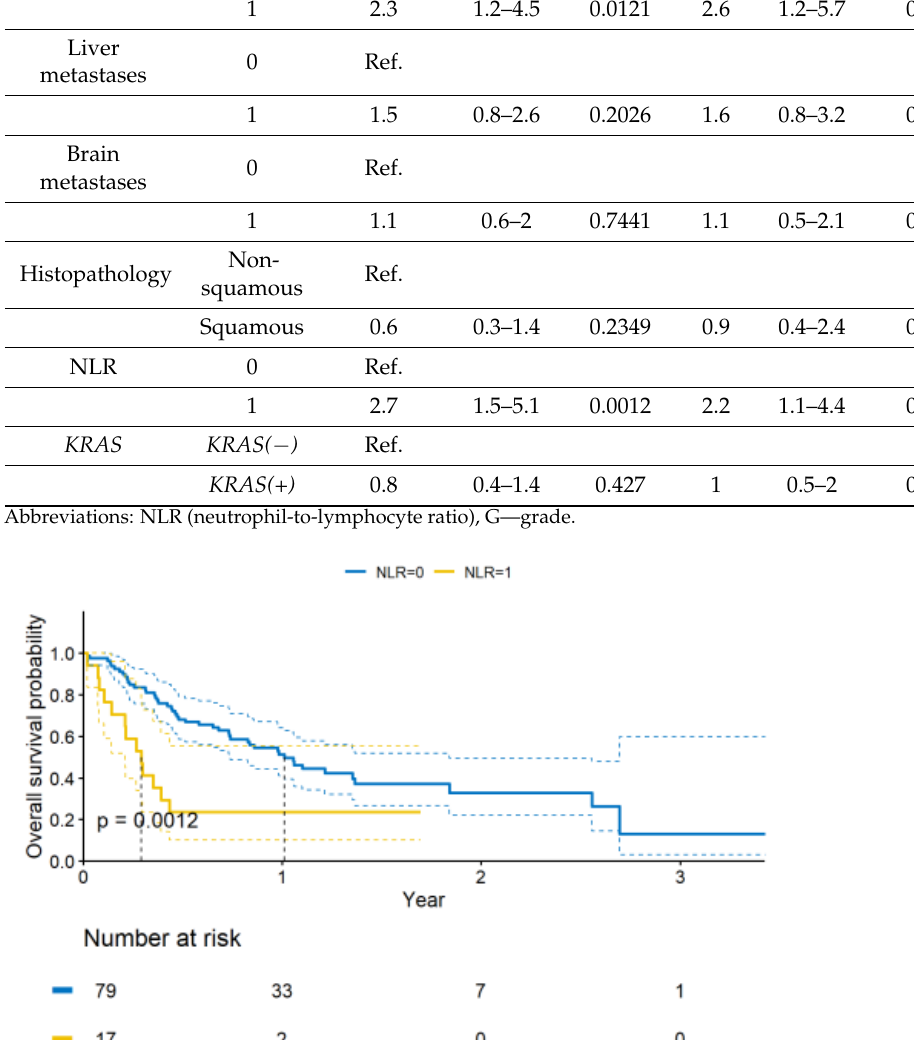
Figure 5. Probability of survival in subgroups by KRAS mutation status.